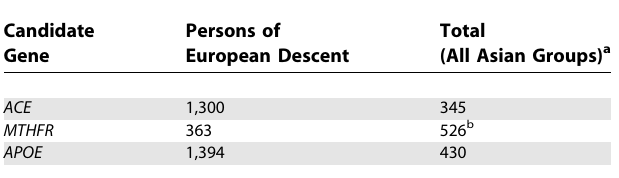
Table 3. Mean Number of Individuals Studied by Gene according to the Ethnic Background